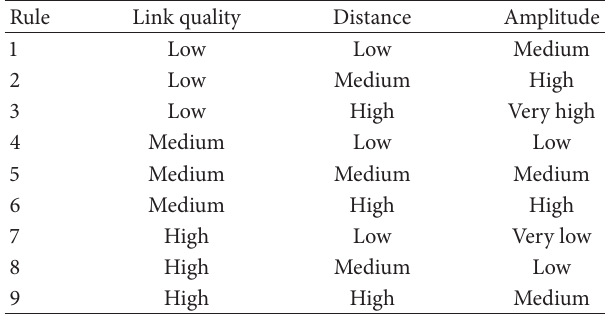
Figure 5: Output variable membership functions representation.